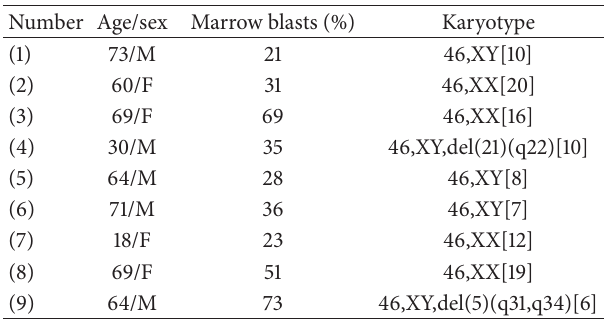
Table 2: The characteristics of postmyelodysplasia acute myeloid leukemia